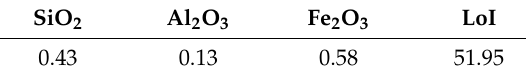
Table 1. Chemical composition of magnesite (wt%).